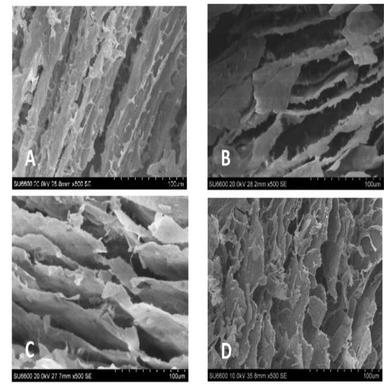
SEM micrographs – PR22.